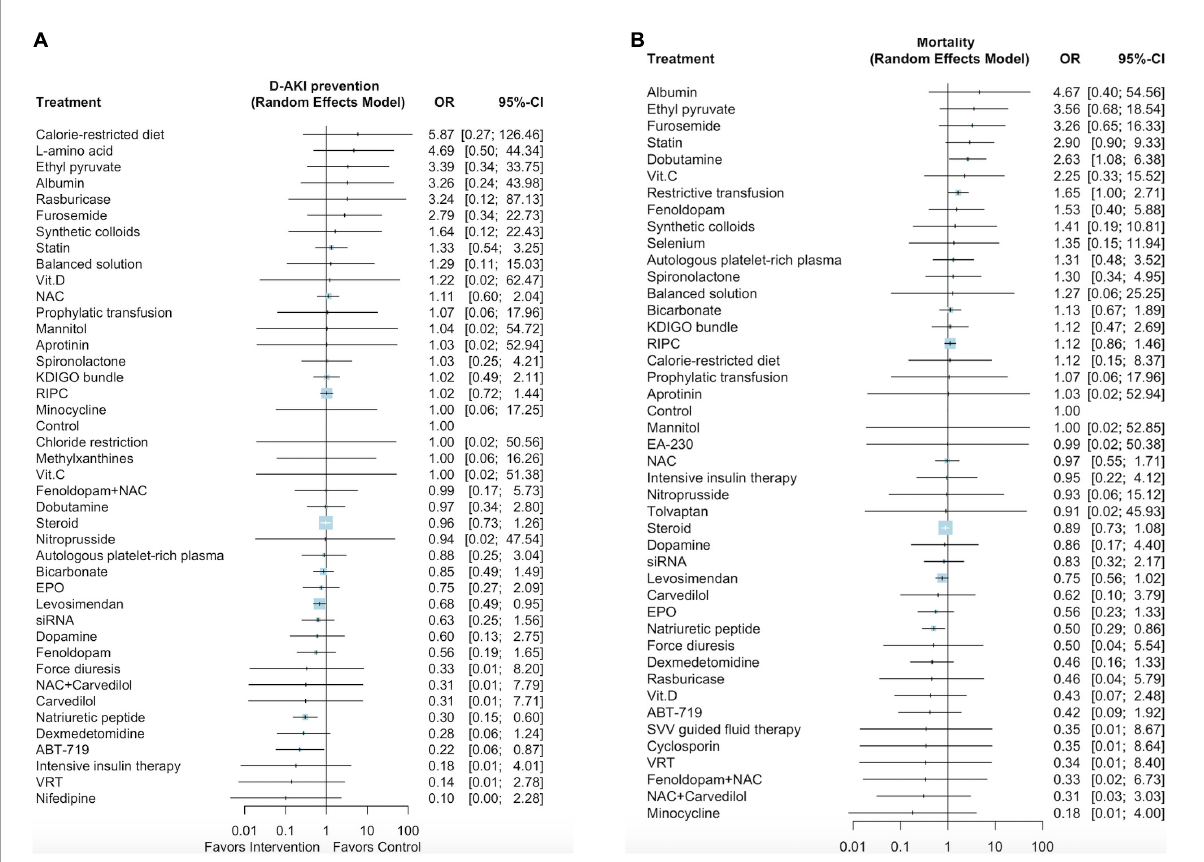
FIGURE2 Forest plot of network meta-analysis for dialysis-requiring AKI prevention (A) , Forest plot for mortality (B)